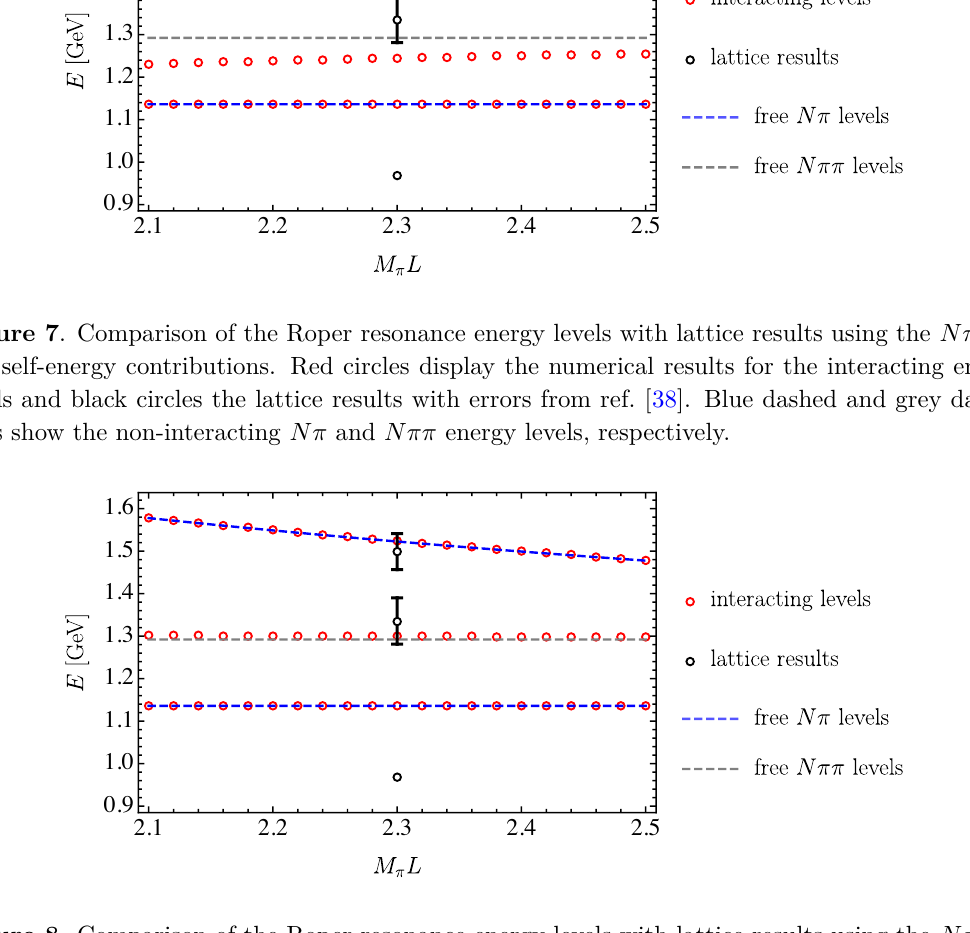
Figure 8 . Comparison of the Roper resonance energy levels with lattice results using the Nπ and ∆ π self-energy contributions. Red circles display the numerical results for the interacting energy levels and black circles the lattice results with errors from ref. [38]. Blue dashed and grey dashed lines show the non-interacting Nπ and Nππ energy levels,